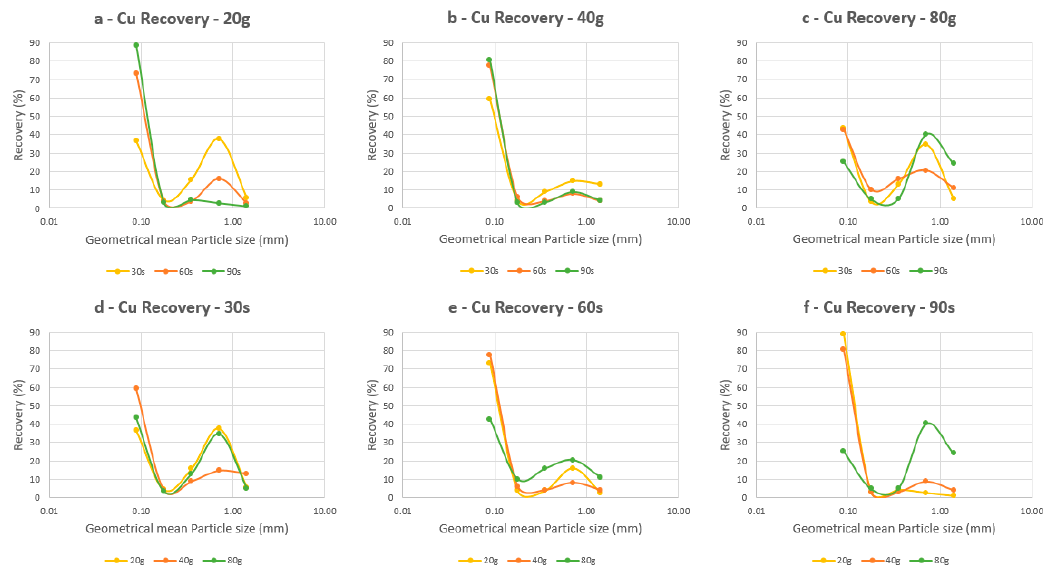
Figure 4. Cu recovery after hammer milling as a function of feed mass, milling time and particle size. Feed size 1–2 mm ( a ) 20 g feed, ( b ) 40 g feed, ( c ) 80 g feed, ( d ) 30 s milling time, ( e ) 60 s milling time, and ( f ) 90 s milling time. Experimental data points are connected with lines for the purpose of visual aid only.